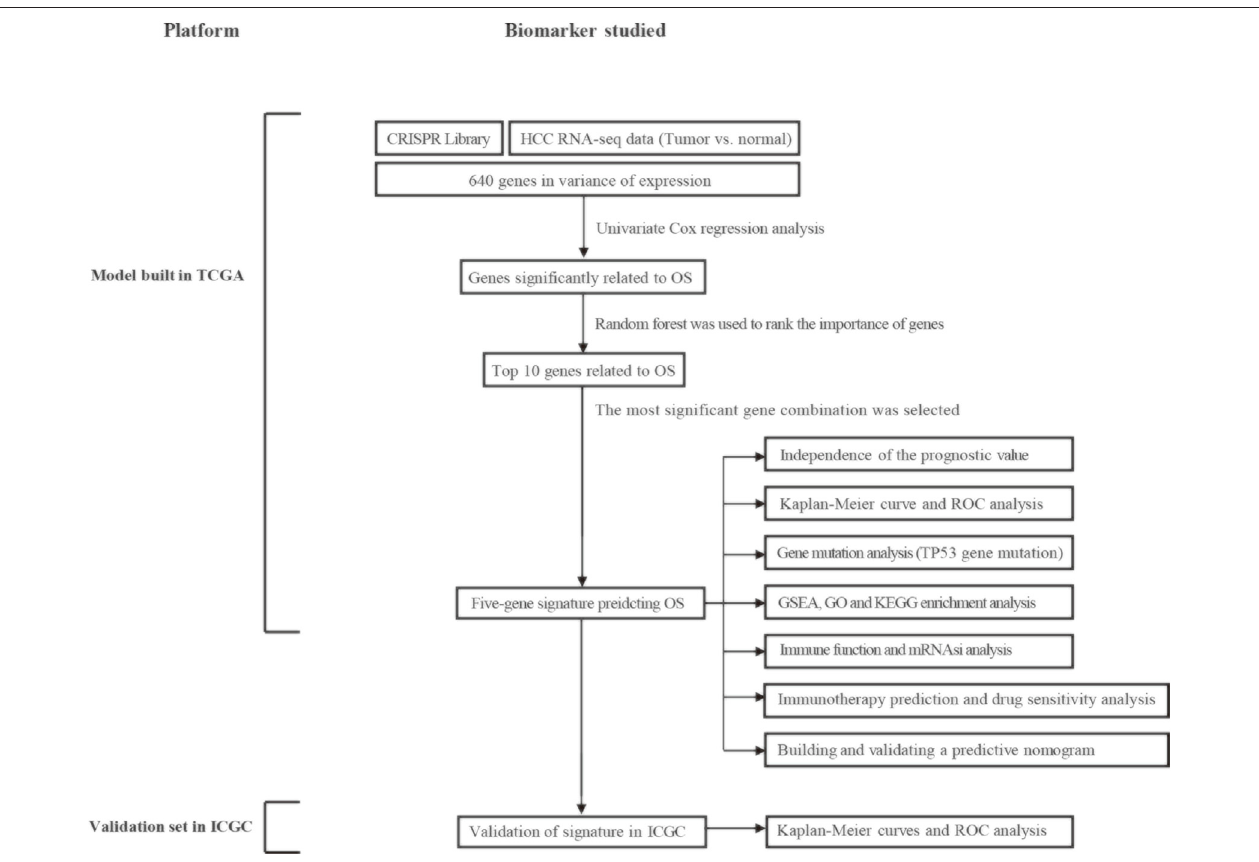
FIGURE1| Overall fl owchartofthisstudy.HCC,hepatocellularcarcinoma;OS,overallsurvival;ROC,receiveroperatingcharacteristic;GSEA,genesetenrichment analysis; GO, gene ontology; KEGG, kyoto encyclopedia of genes and genomes; mRNAsi, mRNA expression-based stemness index.